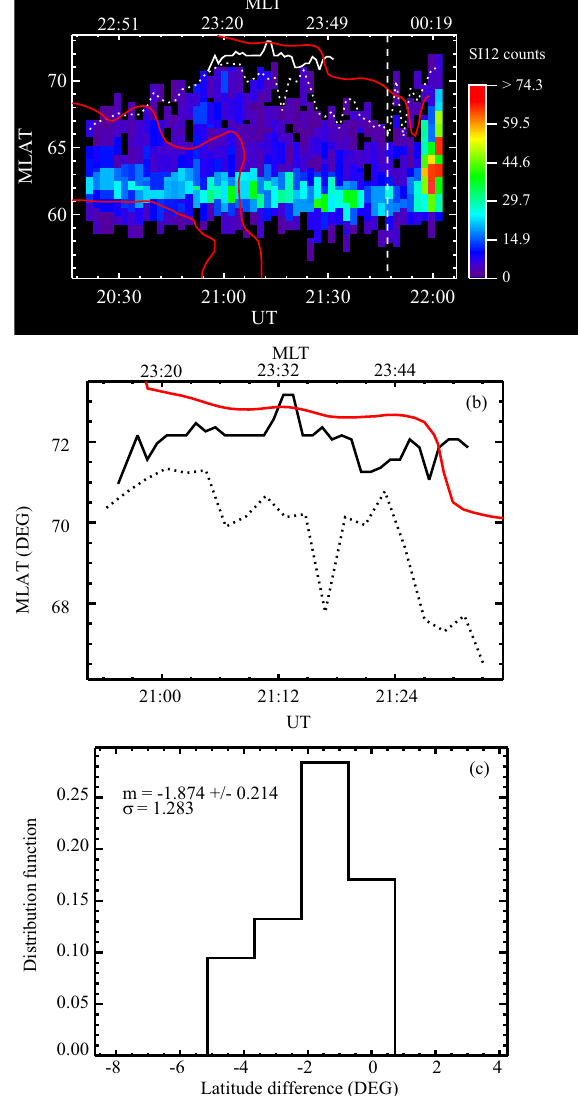
Fig. 7. Same as Fig. 2 for 7 December